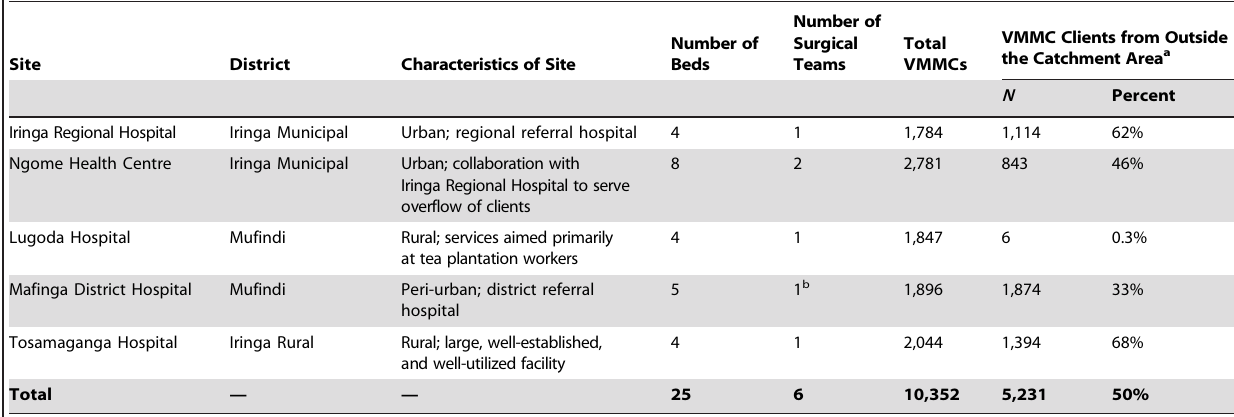
Table 1. VMMCs performed during the campaign, by site.